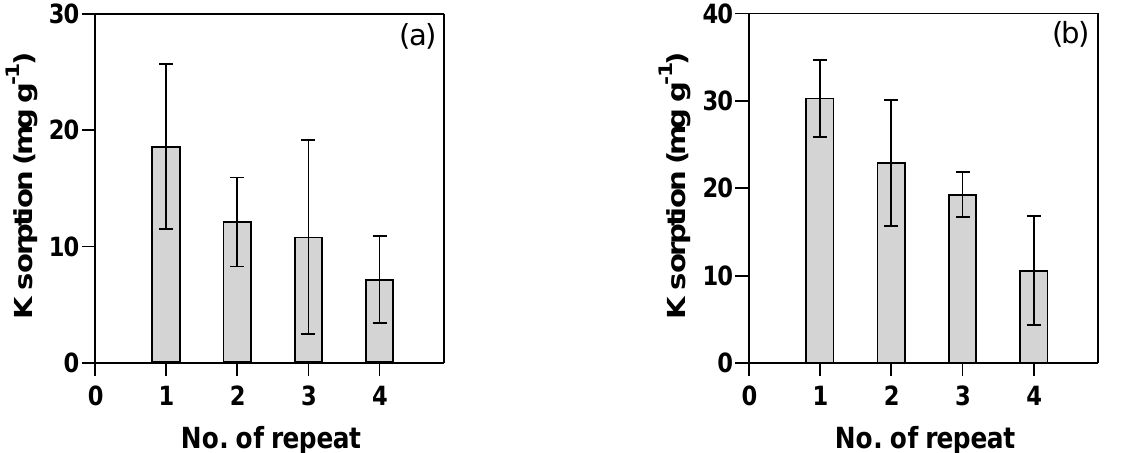
Figure 7. Changes in the potassium (K) sorption capacity with repeated sorption tests: ( a ) natural zeolite; ( b ) ammonium acetate − treated zeolite. The adsorbents were regenerated after each sorption test with 0.5 N HCl.